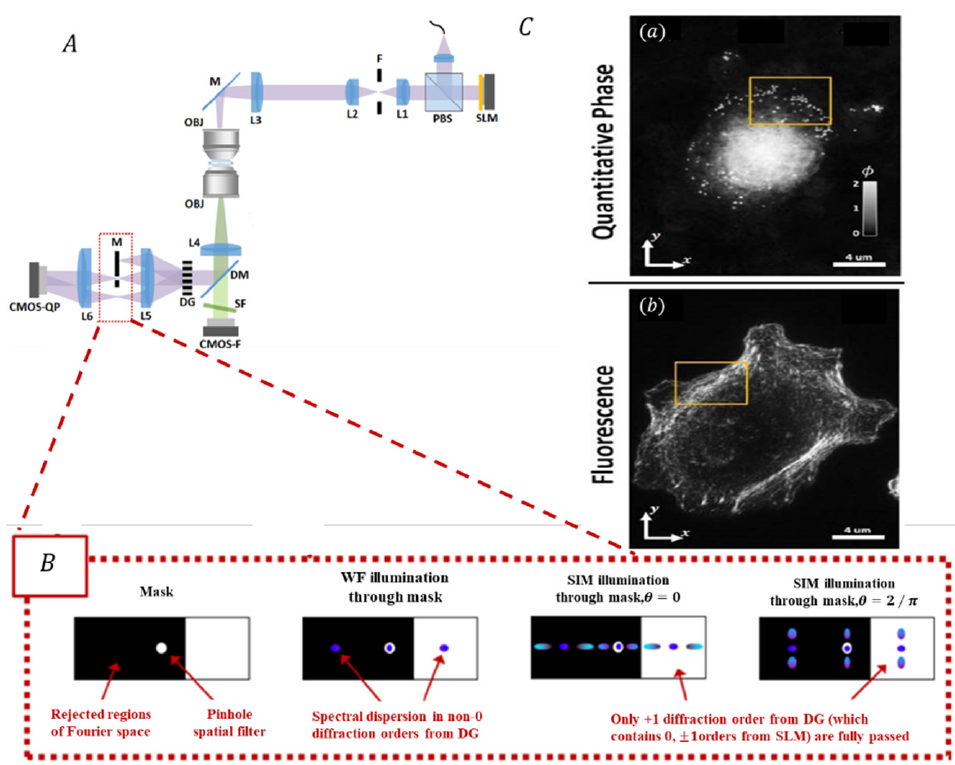
Figure 15. Correlative QP-SIM for multi-modal imaging [145]. ( A ) Schematic diagram of the optical methodology of QP-SIM. ( B ) The mask achieves the detail of off-axis QP imaging. ( C ) Three-dimensional (3D) visualization capabilities of QP-SIM. ( a ) Visualizes a single A549 cell of QP imaging. The vesicles surround the apical portion of the cell are clearly visible in the area outlined in yellow. ( b ) Visualizes a single A549 cell of SIM. The actin morphology of the cell is clearly visible in the area outlined in yellow. Copyright 2017 Biomed Opt Express.